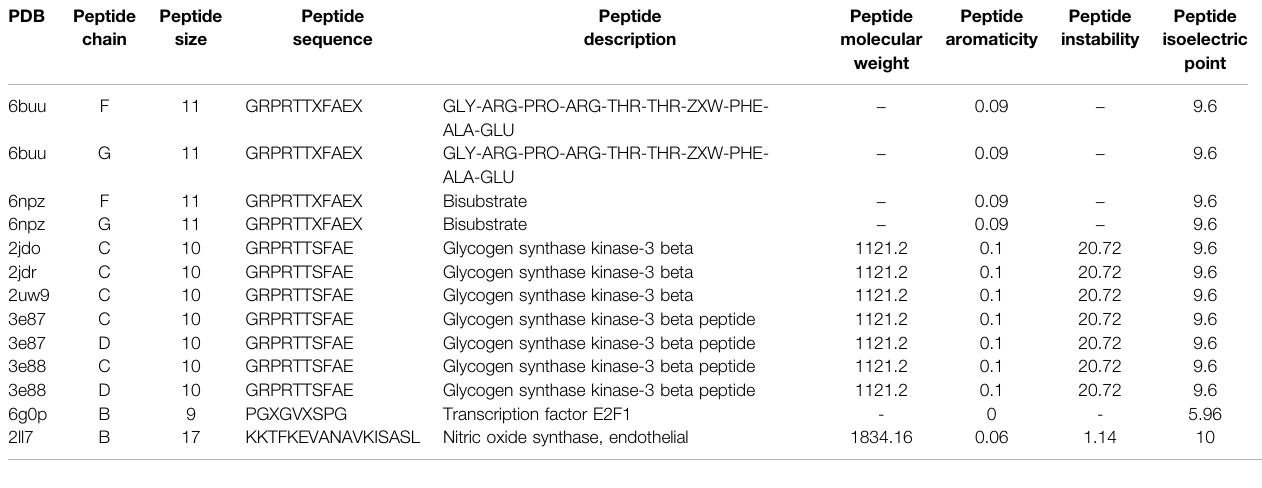
TABLE 3 | Peptide in the CA-related cluster.